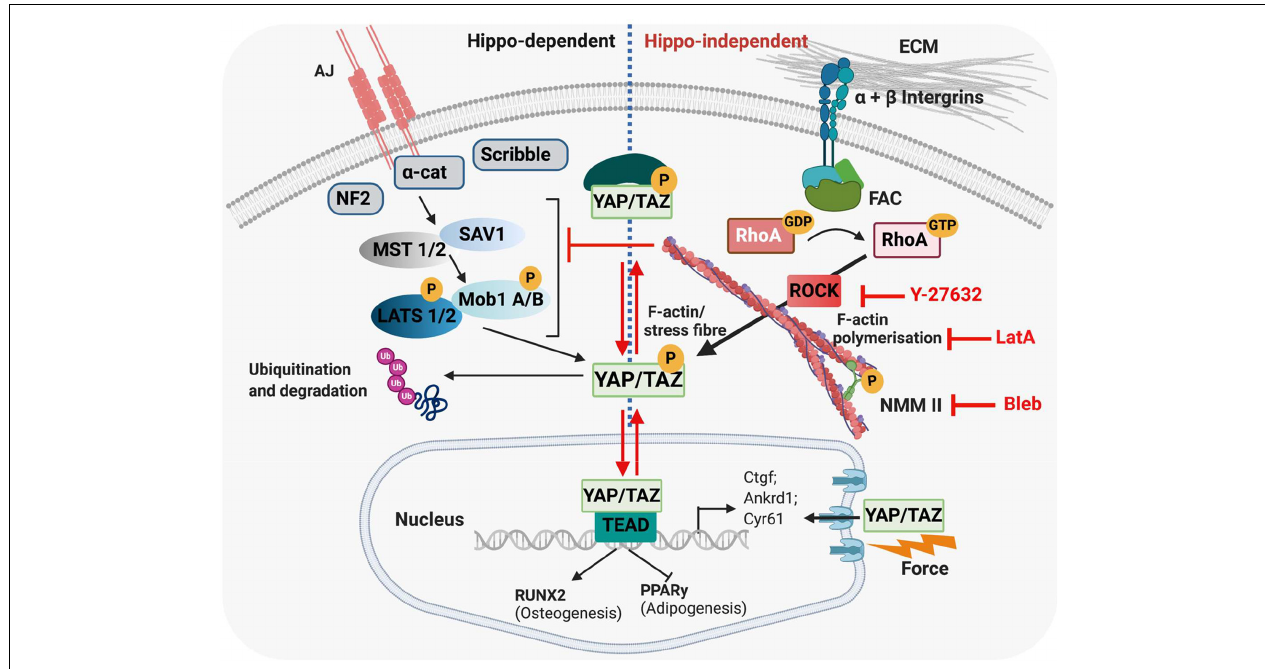
FIGURE 6 | Hippo-dependent and Hippo-independent regulation of YAP/TAZ. YAP/TAZ are known to be regulated via the HIPPO signalling pathway and by a mechanically regulated HIPPO-independent mechanism. (Left) HIPPO control of YAP and TAZ. The HIPPO pathway regulates organ growth as well as cell proliferation, migration and differentiation. In tightly packed tissues, proliferation is regulated by contact inhibition via the HIPPO pathway. Tight junctions and adherens junctions between cells interact with and activate MST1/2, which recruit SAV1, and subsequently phosphorylate LATS1/2. This phosphorylation is facilitated by the scaffold proteins MOB1 A/B and NF2. In turn, LATS1/2 phosphorylate YAP/TAZ, leading to cytoplasmic sequestering of these proteins, and their eventual ubiquitination/degradation. F-actin has been proposed to regulate YAP/TAZ localisation via the HIPPO pathway by inhibiting LATS1/2 and/or upstream factors, thus preventing phosphorylation and cytoplasmic retention of YAP/TAZ. (Right) ECM stiffness also regulates YAP/TAZ in a HIPPO-independent mechanism. Cells interact with their ECM via integrins; in stiff environments, focal adhesion assembly is promoted, which activates Rho-ROCK signalling, which in turn activates F-actin stress fibre formation and translocation of YAP/TAZ to the nucleus, where these proteins regulate gene expression via activation of TEAD1-4. External application of force to the nucleus has also been shown to open nuclear pores and allow increased YAP/TAZ entry into the nucleus. Cytoskeletal inhibitors affect different parts of the mechanotransduction pathway; Y-27632 inhibits ROCK, Latrunculin A inhibits F-actin polymerisation and Blebbistatin inhibits Myosin (all depicted in red). MST1/2, mammalian ste-20-like kinases 1/2; SAV1, salvador family WW domain containing protein 1; LATS1/2, large tumour suppressors 1/2; MOB1 A/B, MOB kinase activator 1A; NF2, neurofibromatosis type 2; TEAD1-4, TEA domain family member 1-4; FAC, focal adhesion kinase. Created using